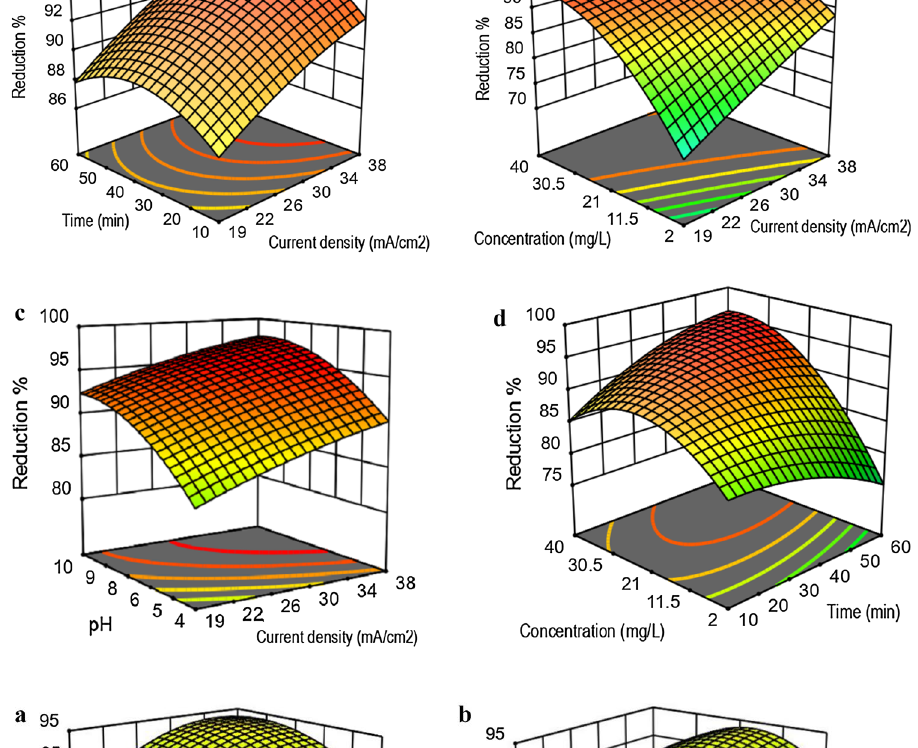
Fig. 8 Surface plots with con- tour as a function of a treatment time and current density at pH 6.5 and initial concentration 21 mgF/L, b initial concentra- tion and current density at pH 6.5 and treatment time 35 min, c pH and current density at initial concentration of 21 mgF/L and time 35 min, d concentration and time at current density 12.4 mAcm −2 and pH